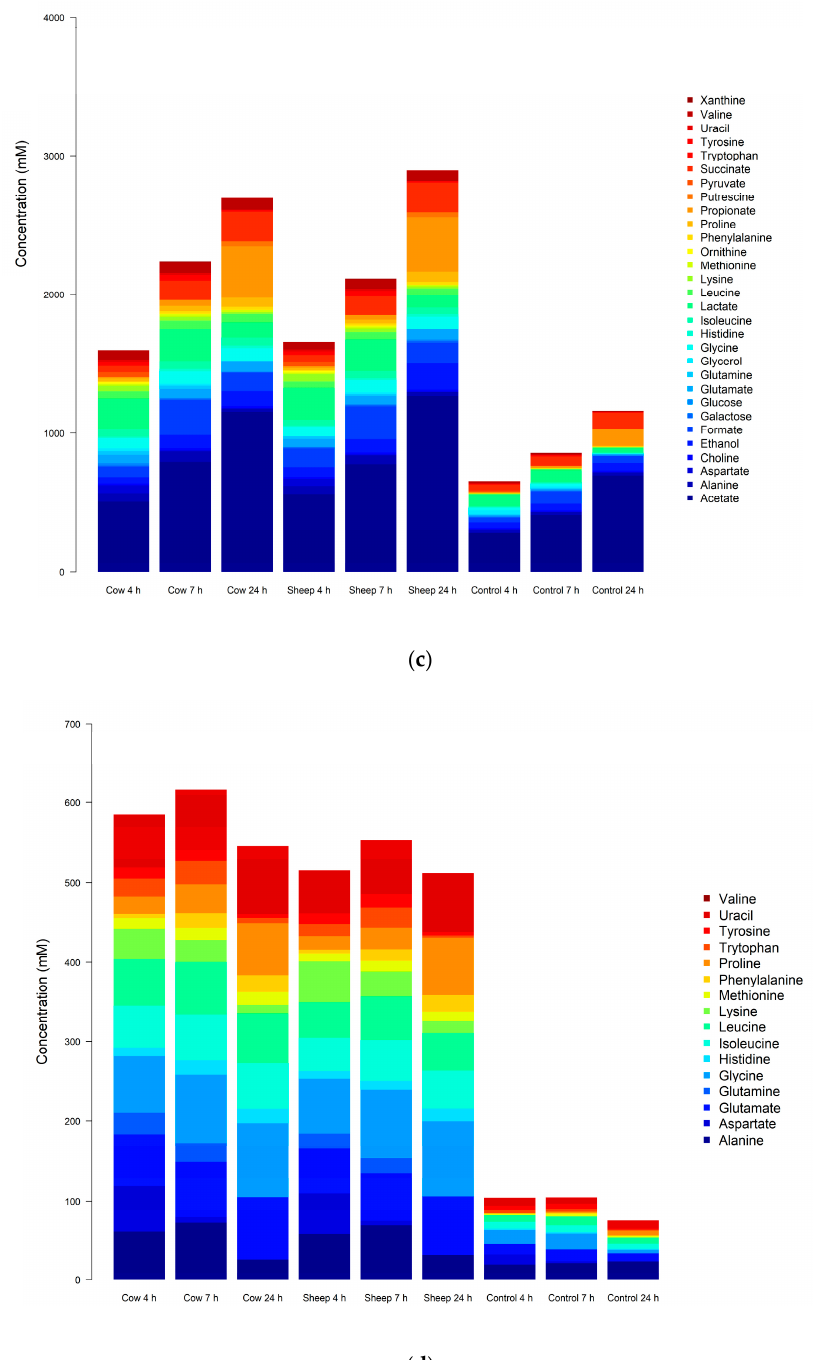
Figure 4. ( a ): One-month-old infant fecal fermentations—all metabolites with significantly different concentrations between all treatment groups, detected by NMR spectroscopy. ( b ): One-month-old infant fecal fermentations—amino acids with significantly different concentrations between all treatment groups, detected by NMR spectroscopy. ( c ): Five-month-old fecal fermentations—all metabolites with significantly different concentrations between all treatment groups, detected by NMR spectroscopy. ( d ): Five-month-old fecal fermentations—amino acids with significantly di ff erent concentrations between all treatment groups, detected by NMR